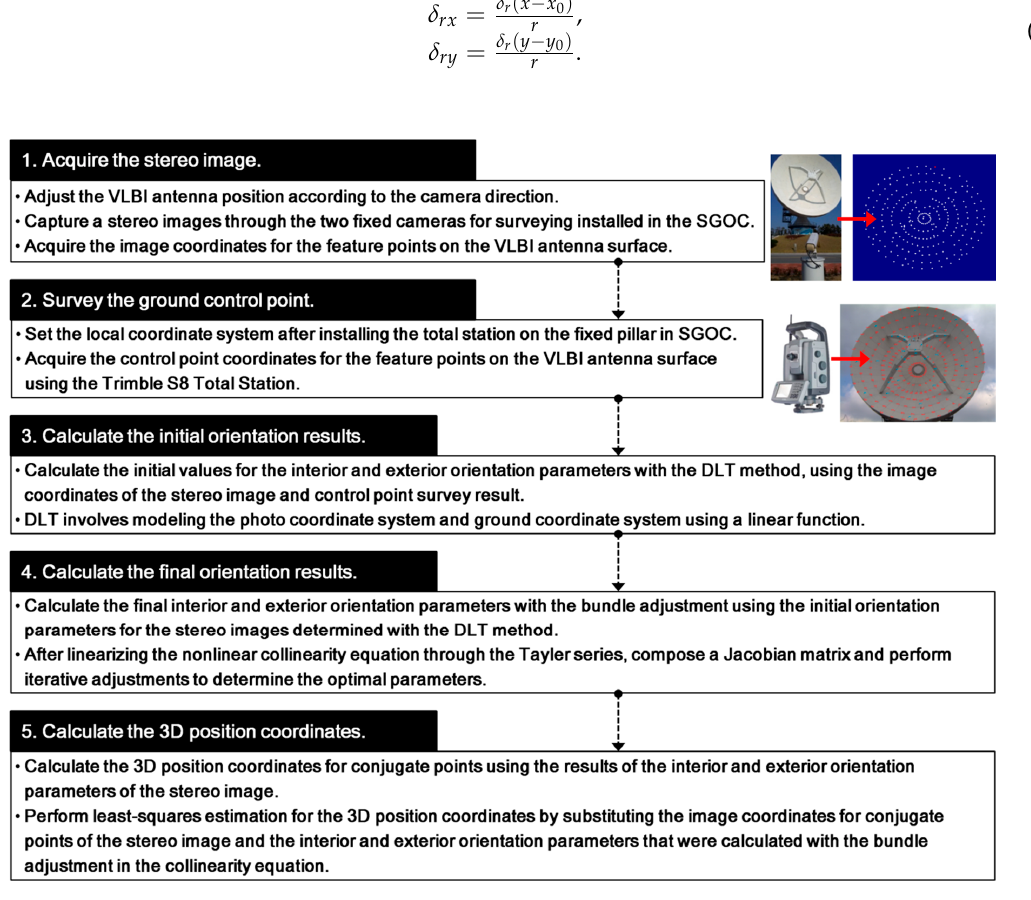
Figure 8. Calculation process for interior and exterior orientation results.